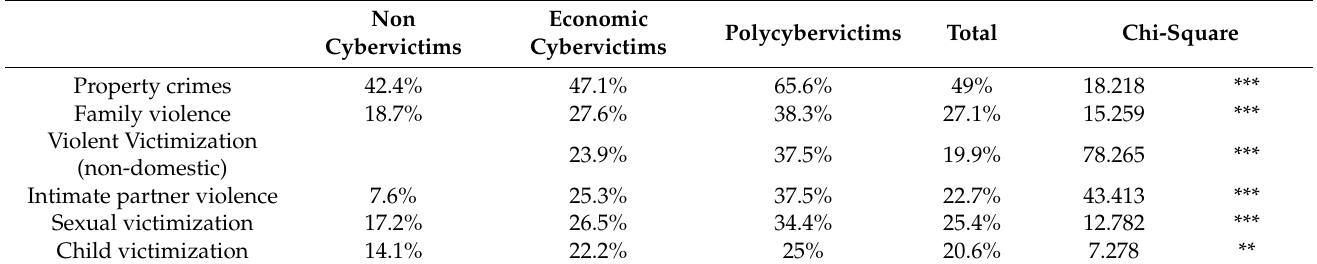
Table 4. Latent classes. Differences related to offline